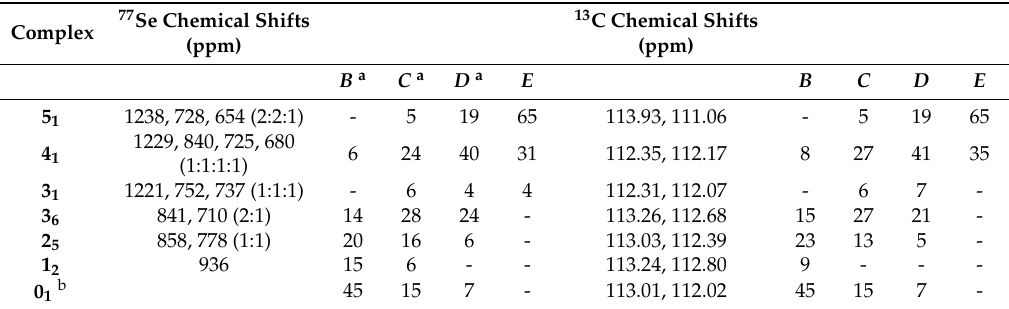
Table 2. Semiquantitative determination of the contents (mol%) of the [TiCp 2 Se x S 5 − x ] complexes in phases B – E based on the relative intensities observed in the 77 Se and 13 C NMR spectra of the reaction mixtures recorded in carbon disulfide.